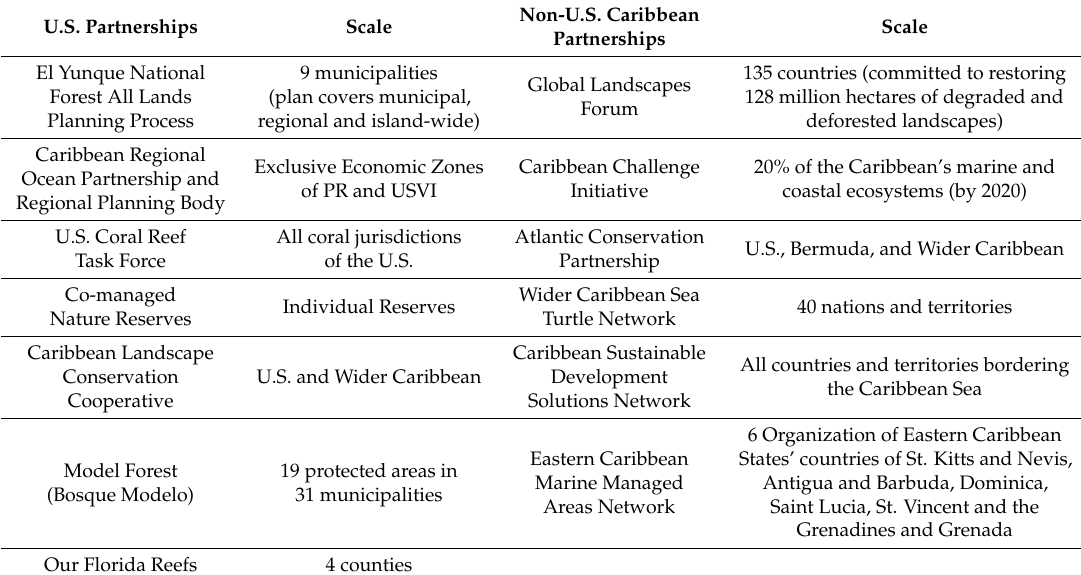
Table 1. Examples of large-scale partnerships in the United States Caribbean and Non-U.S. Caribbean. U.S.